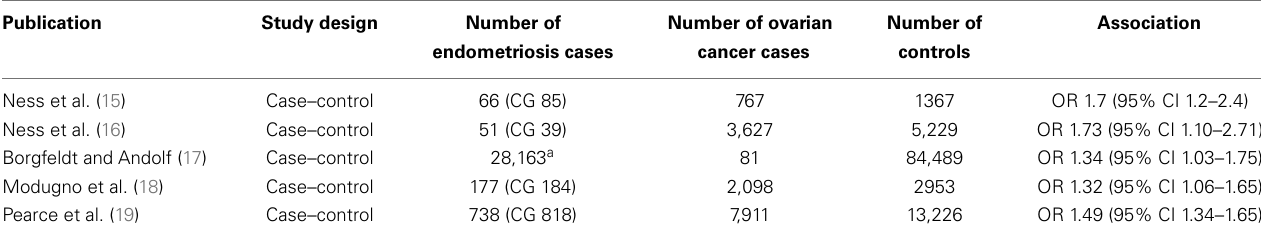
Table 1 | Overview of case–control studies assessing the association between endometriosis and ovarian cancer